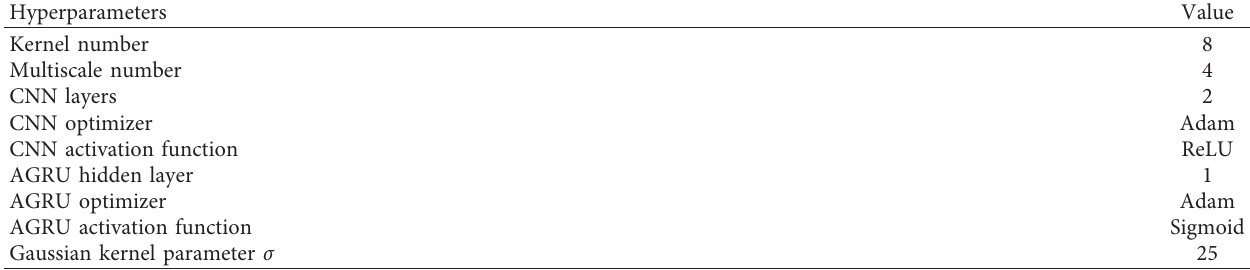
Table 2: Model hyperparameters.